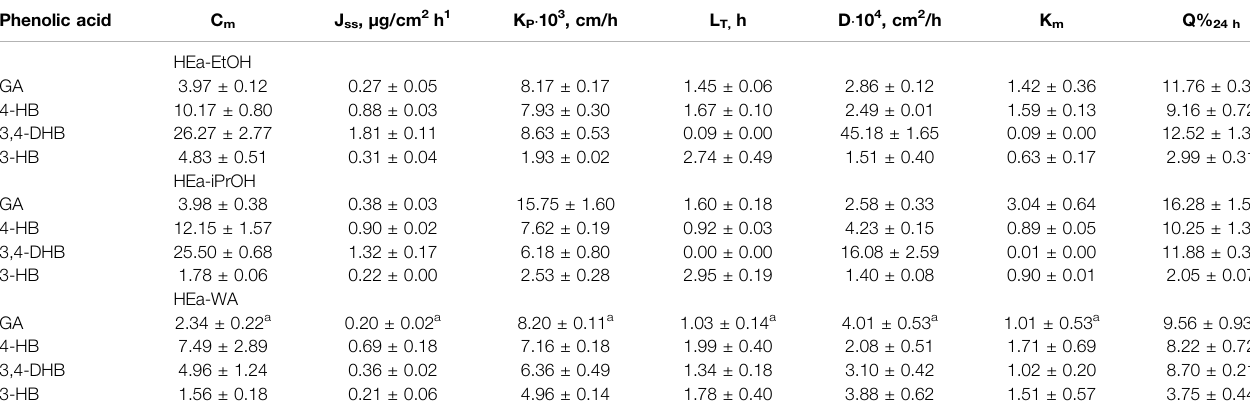
TABLE 5 | The parameters characterize phenolic acids transport through the skin after applying HEas in the penetration study. Phenolic acid C